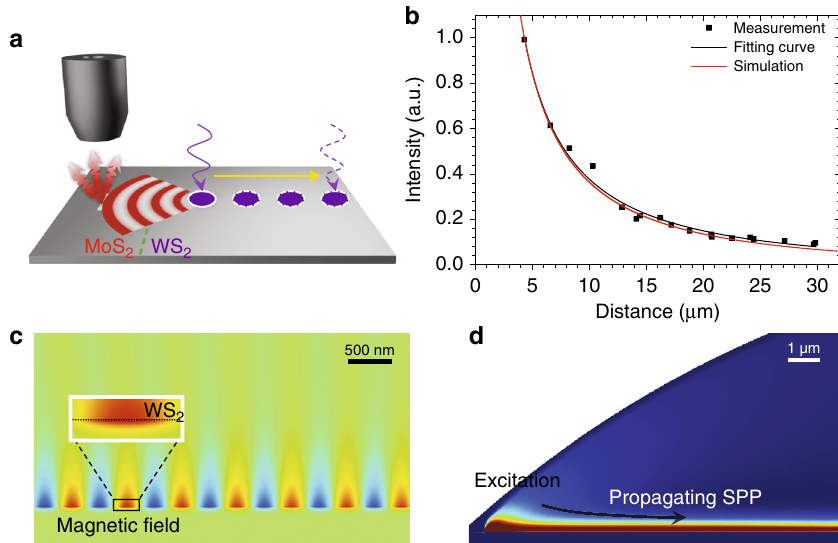
Fig. 3 Measurements and simulations of exciton energy propagation process. a Schematic of measurement geometry for determining the exciton energy propagation length. The PL intensity is collected at a fi xed location on the MoS 2 region, beneath which a groove is fabricated on the Ag plate. The excitation laser spot is moved away from the groove during measurements. b Measured PL intensity ( black points ) vs. increasing distance between the collection and launching sites. Two curves correspond to a fi tting result ( black curve ) and the simulated energy decay behaviour in the MOS structure ( red curve ). c Simulated near- fi eld pro fi le suggests that a signi fi cant percentage of the transferred energy is distributed outside of the TMD LHS monolayer. d Simulated power-density pro fi le and the decay behavior along the propagation